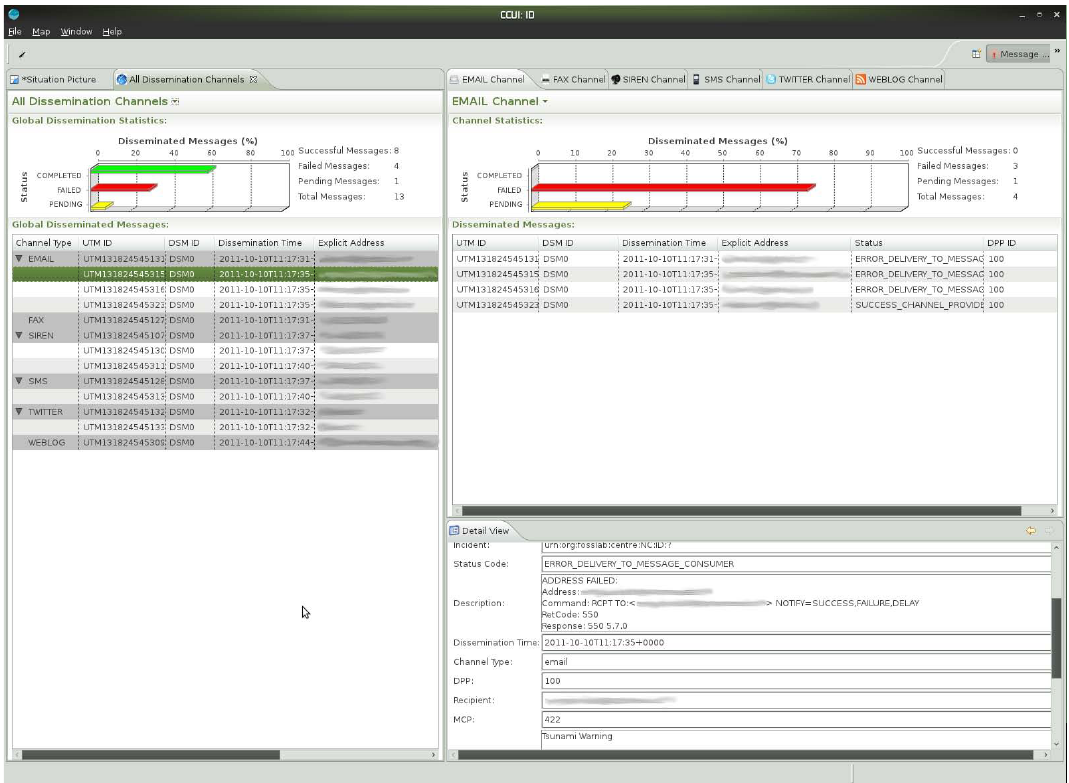
Fig. 10. Dissemination